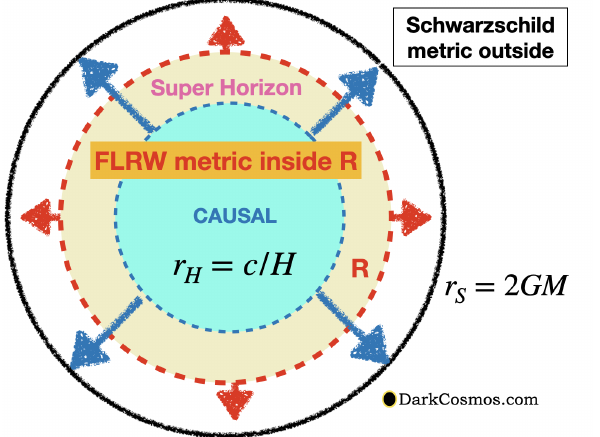
Figure 3. Illustration of our Universe inside the event horizon r S = 2 GM . This is a Schwarzschild (empty) metric outside ( r > R ) and an FLRW metric inside R (red dashed line) with mass M . The Hubble radius r H = c / H (dashed line) defines the volume inside causal contact (blue shading) from r S ] 1/3 , so that R grows slower than the center. The BHU solution in Equation (11) requires R = [ r 2 H r H . There is a region with matter outside the Hubble radius R > r > r H (yellow shading) with super horizon (or frozen) perturbations. This solves the horizon problem in Cosmology and is a source for perturbations that enter the horizon as the metric expands, creating LSS and BAO in Cosmic Maps, pretty much like what is usually assumed for Cosmic